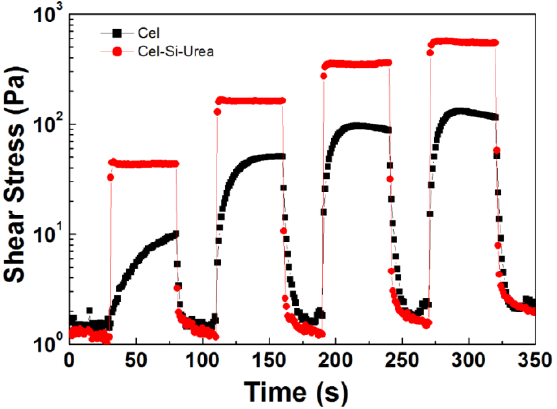
Figure 10. Shear stress of the ER fluids based on pristine cellulose (square) and decorated cellulose (circle) at the square voltage pulse electric field.